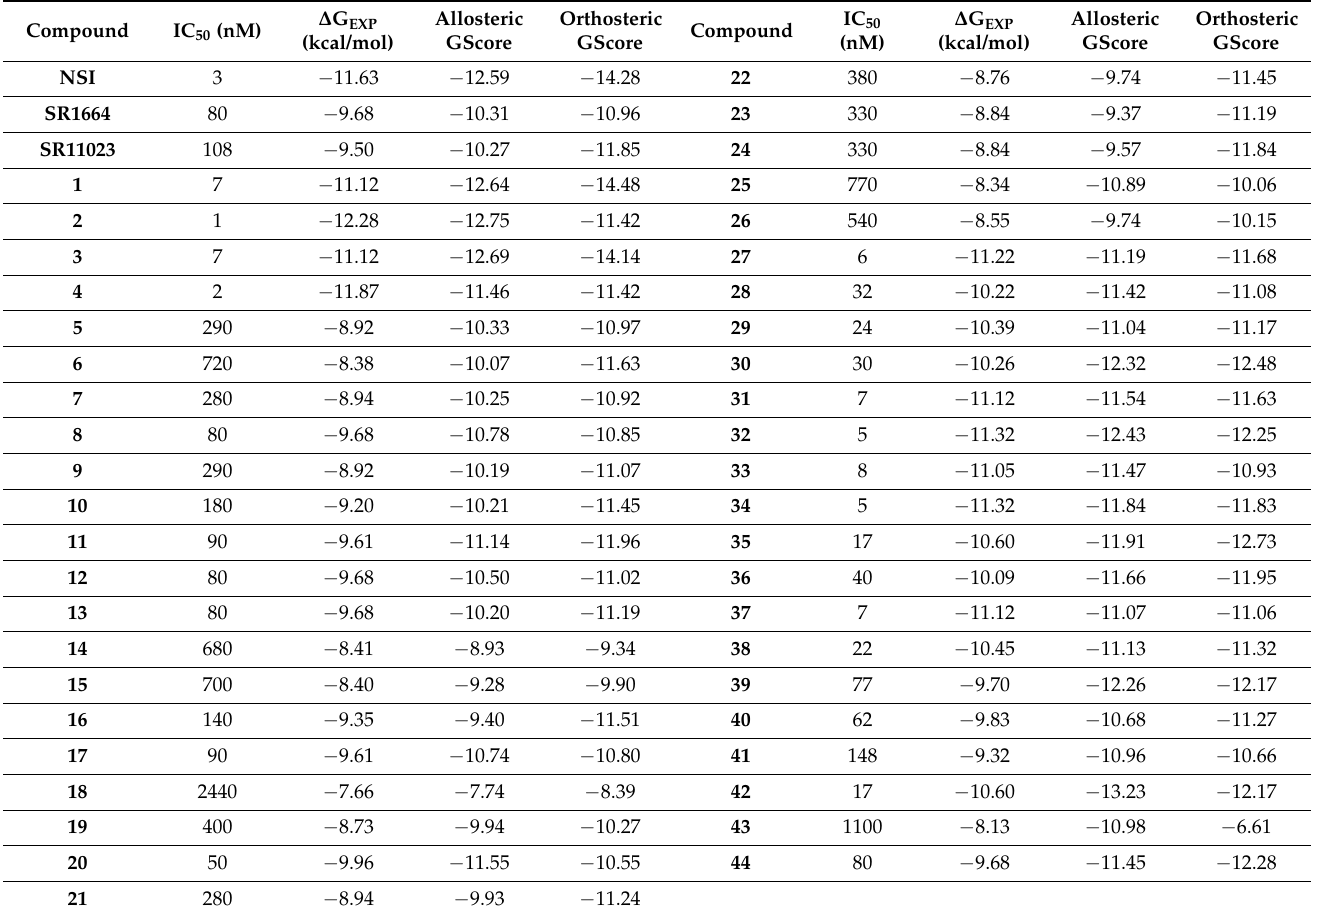
Table 1. The glide score (kcal/mol) for the 47 PPAR γ antagonists against the allosteric and orthosteric binding